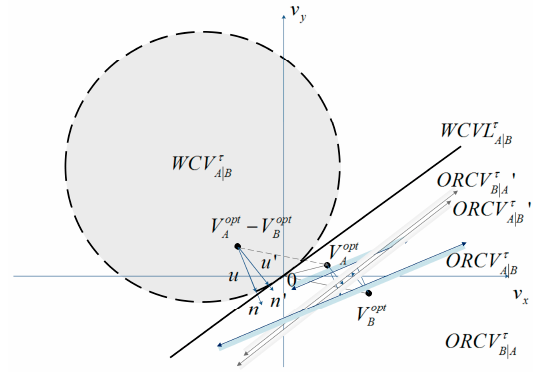
ORCV for UAV A relative to B . Figure 3. Two approaches of describing ORCV τ for UAV A relative to B . AB A | B and v new respectively, which satisfies that v new B